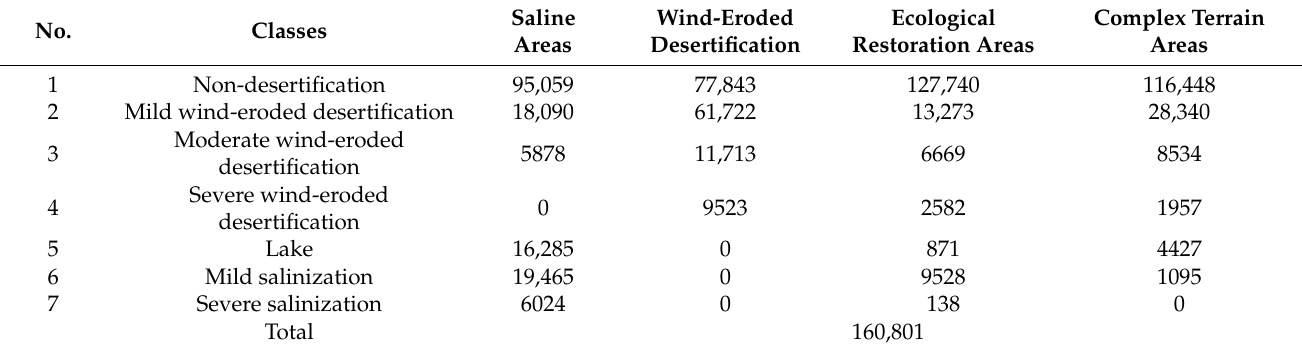
Table 1. Number of samples of each type in four datasets.